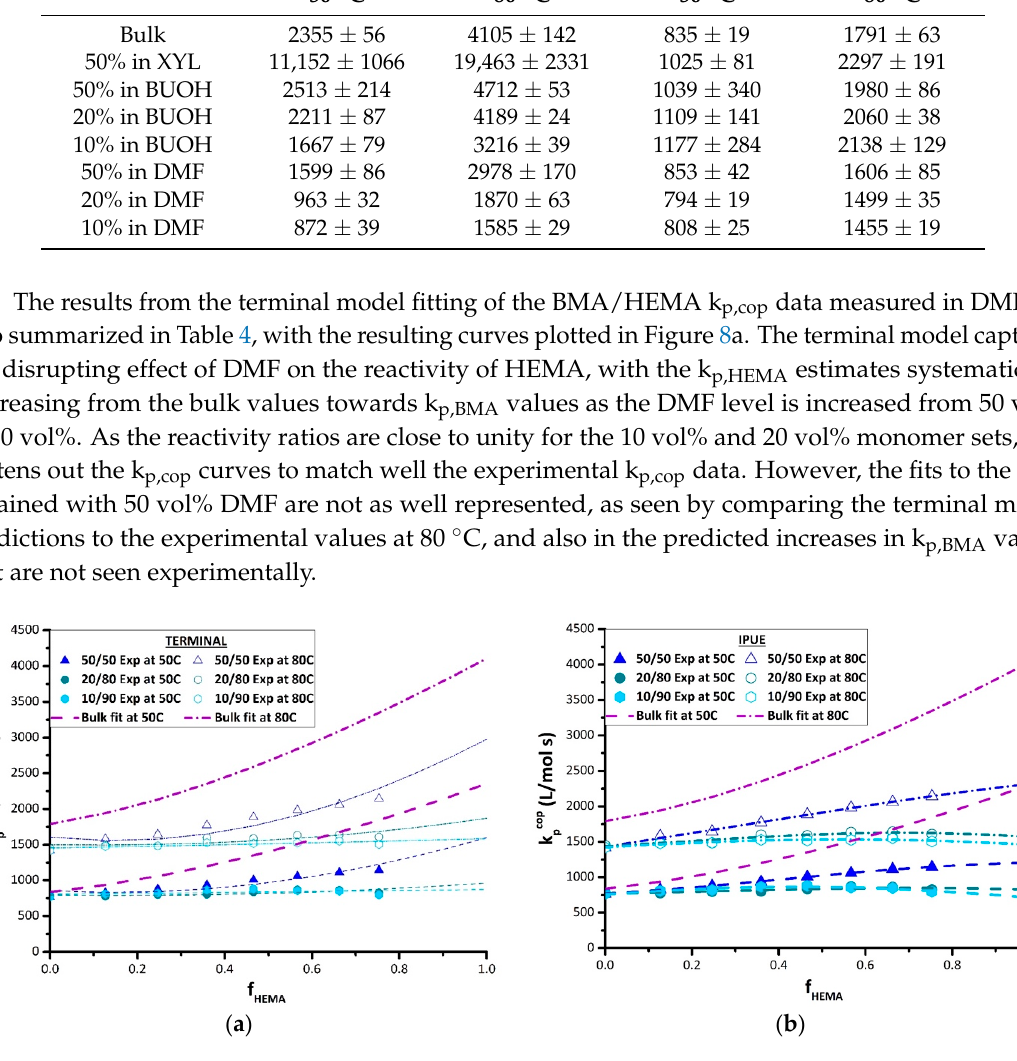
Figure 8. ( a ) Terminal and ( b ) implicit unit (IPUE) model fits (lines) to BMA/HEMA k p,cop data (points) determined at 50 and 80 °C by PLP-SEC experimentation in DMF at different monomer/solvent volume ratios (see legends), with parameter estimates summarized in Table 4 (terminal model) and Table 5 (IPUE).